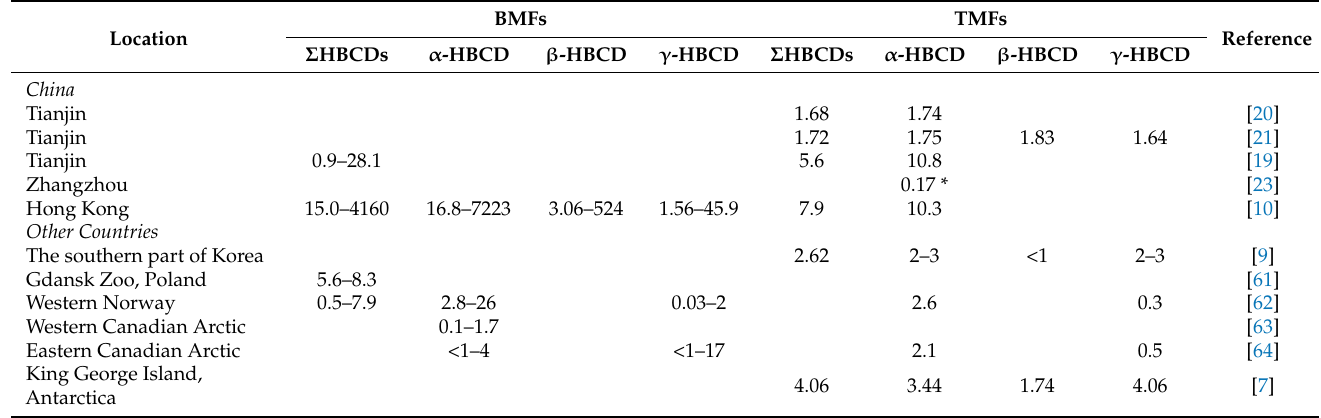
Table 2. Biomagnification factors (BMFs) and trophic magnification factors (TMFs) of HBCDs (lipid- weight basis) in marine food web from China and other